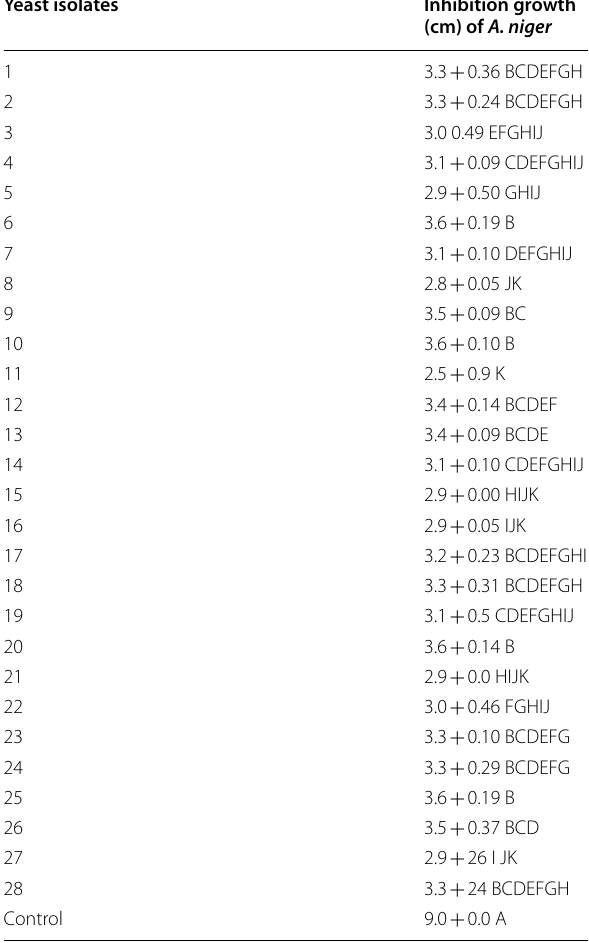
Values within the same column that are associated with different letters indicate significant differences ( P 0.05). Four replicates were used in this experiment ≤